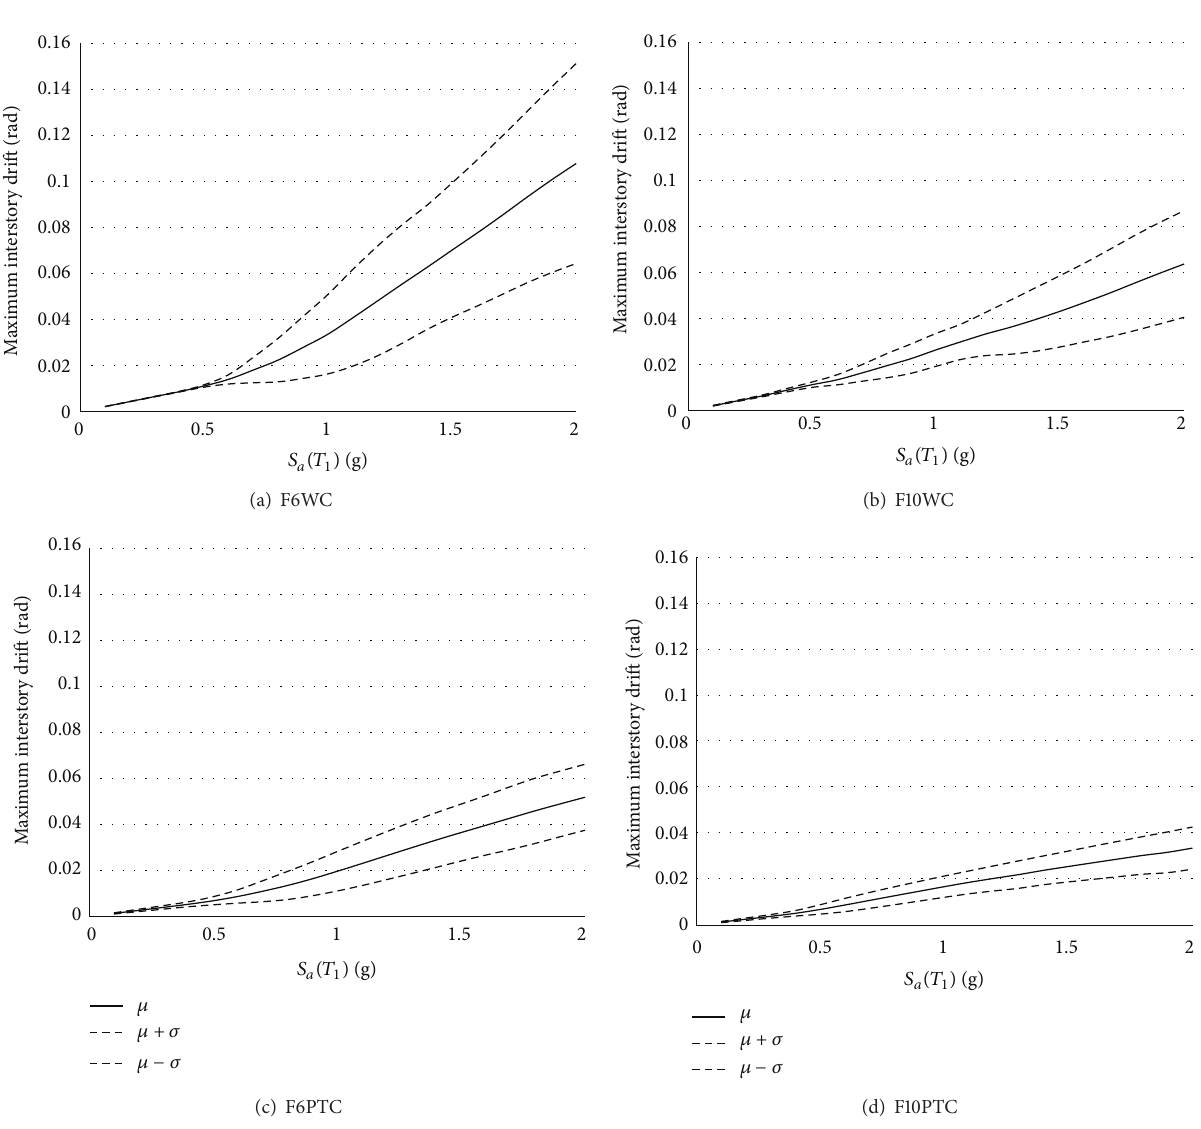
Figure 5: Median values of maximum interstory drifts ± one standard deviation for models: (a) F6WC, (b) F10WC, (c) F6PTC, and (d)